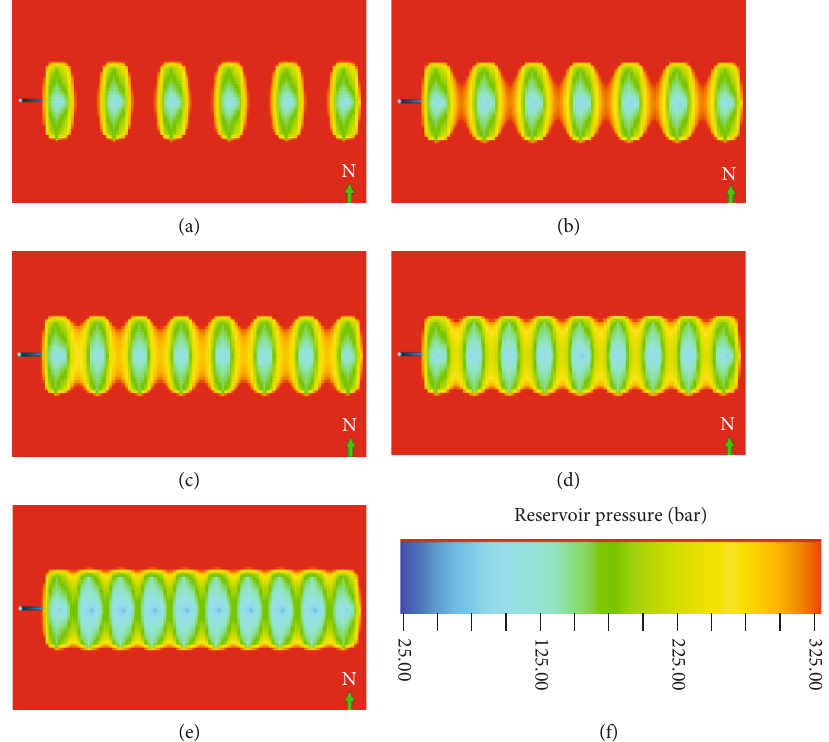
Figure 8: End-production pressure distribution under di ff erent fracture numbers: (a) 6 fractures, (b) 7 fractures, (c) 8 fractures, (d) 9 fractures, (e) 10 fractures, and (f) the legend of reservoir pressure. Table 6: Peak and cumulative gas production at fracture number.